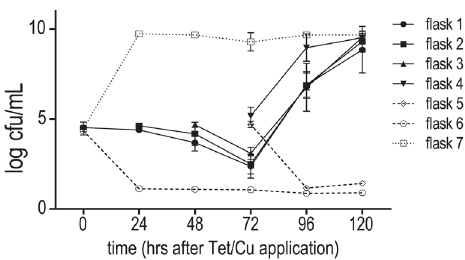
Figure 5. Chelation of tetracycline by copper. X-axis is time in hrs after adding copper and tetracycline (flasks 1–4, solid lines), tetracycline (flasks 5 & 6, dashed lines), or copper (flask 7, dotted line). The first data point in each series indicates time of inoculation with E. coli BW25113. Values are means of three independent experiments ±